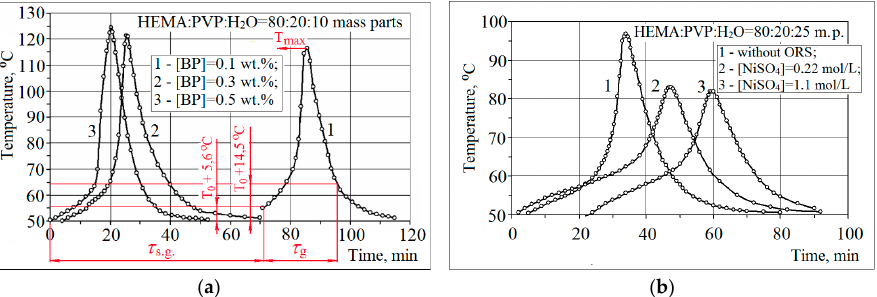
Figure 1. Thermometric curves of polymerization depending on the initiator (benzoyl peroxide (BP)) content ( a ) and oxidation-reducing system (ORS) composition ( b ).